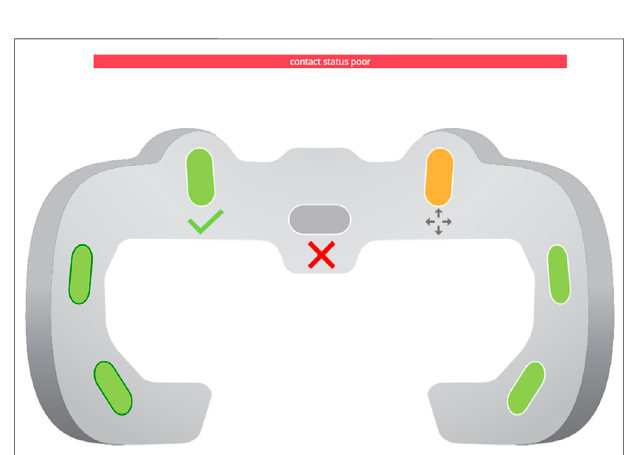
FIGURE 9 | SuperVision mask diagram displaying EMG signal quality. Green (good signal), Orange (weak signal), Grey (no contact).